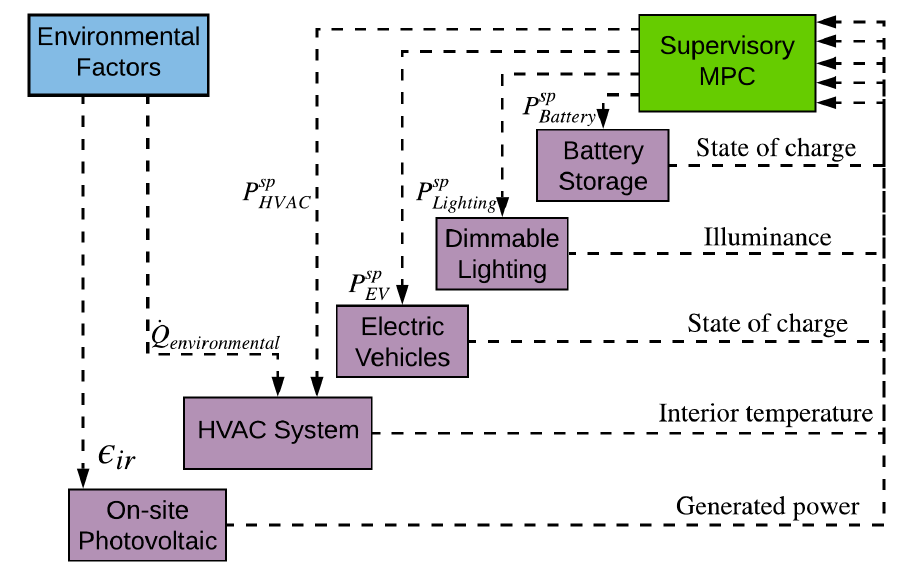
Figure 1. Supervisory control, optimization and coordination